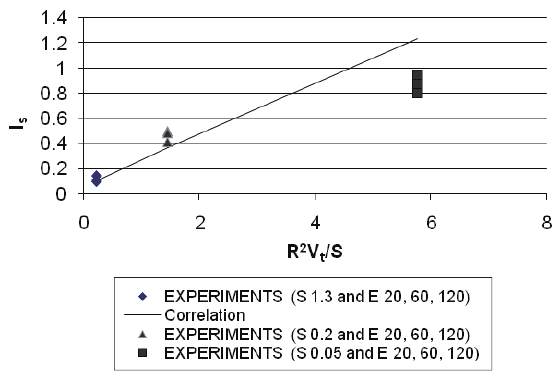
Fig. 4 Segregation index predicted (straight line) com- pared to experiments with three different pow- der feeding rates and air extraction